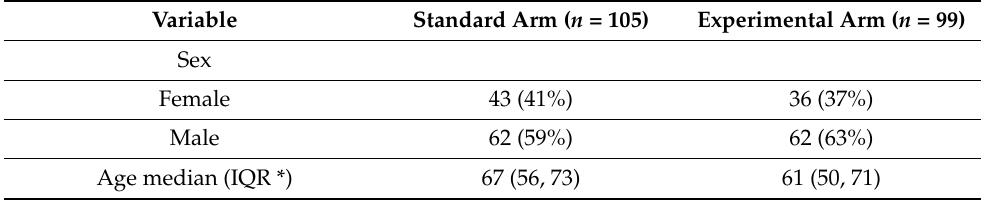
Table 1. Patient